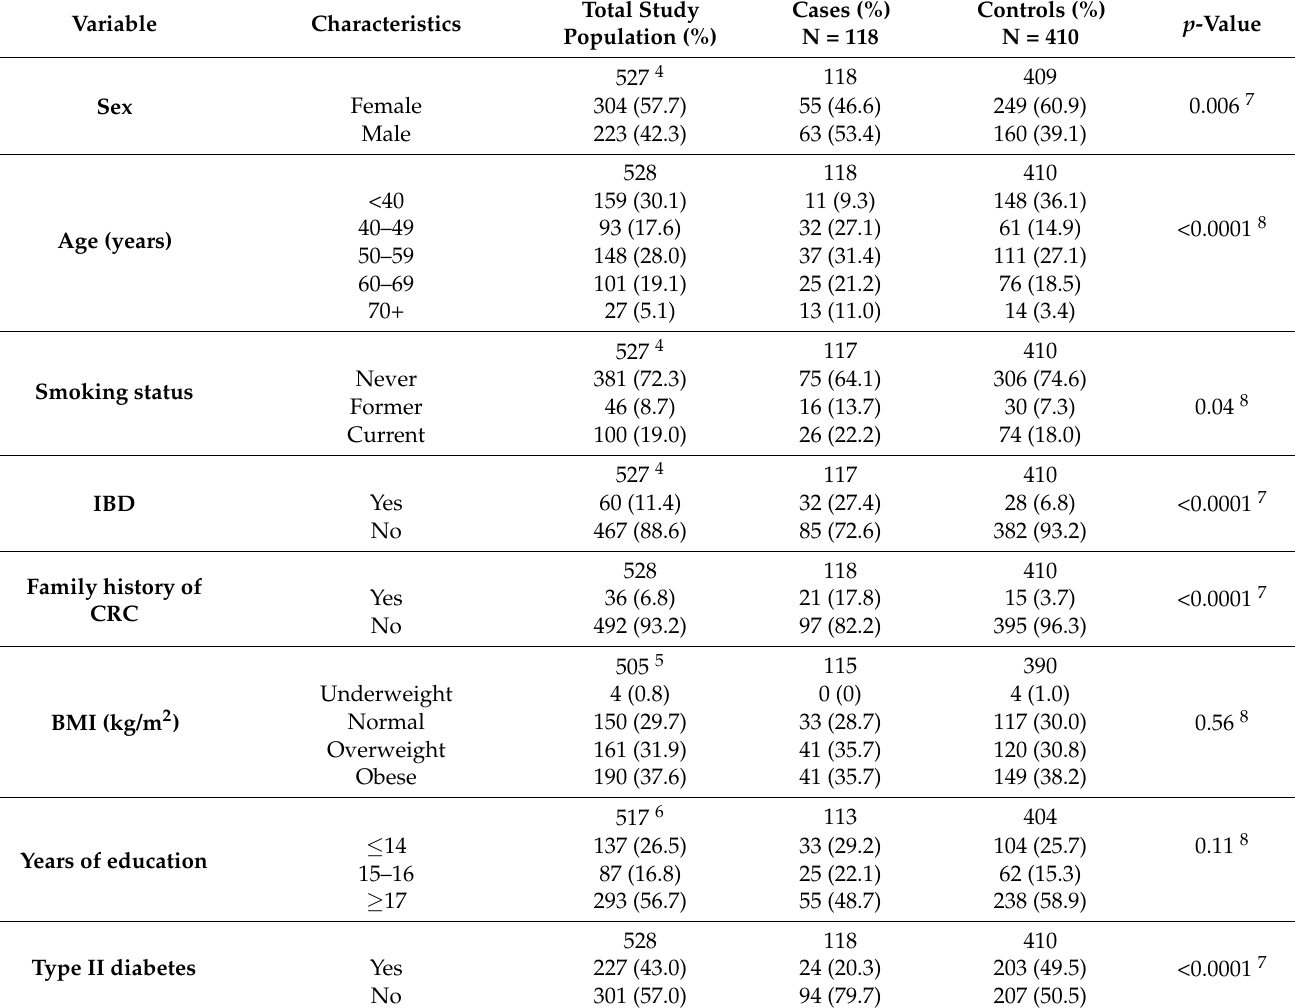
Table 1. Descriptive statistics for participants’ clinical and epidemiological characteristics (N =